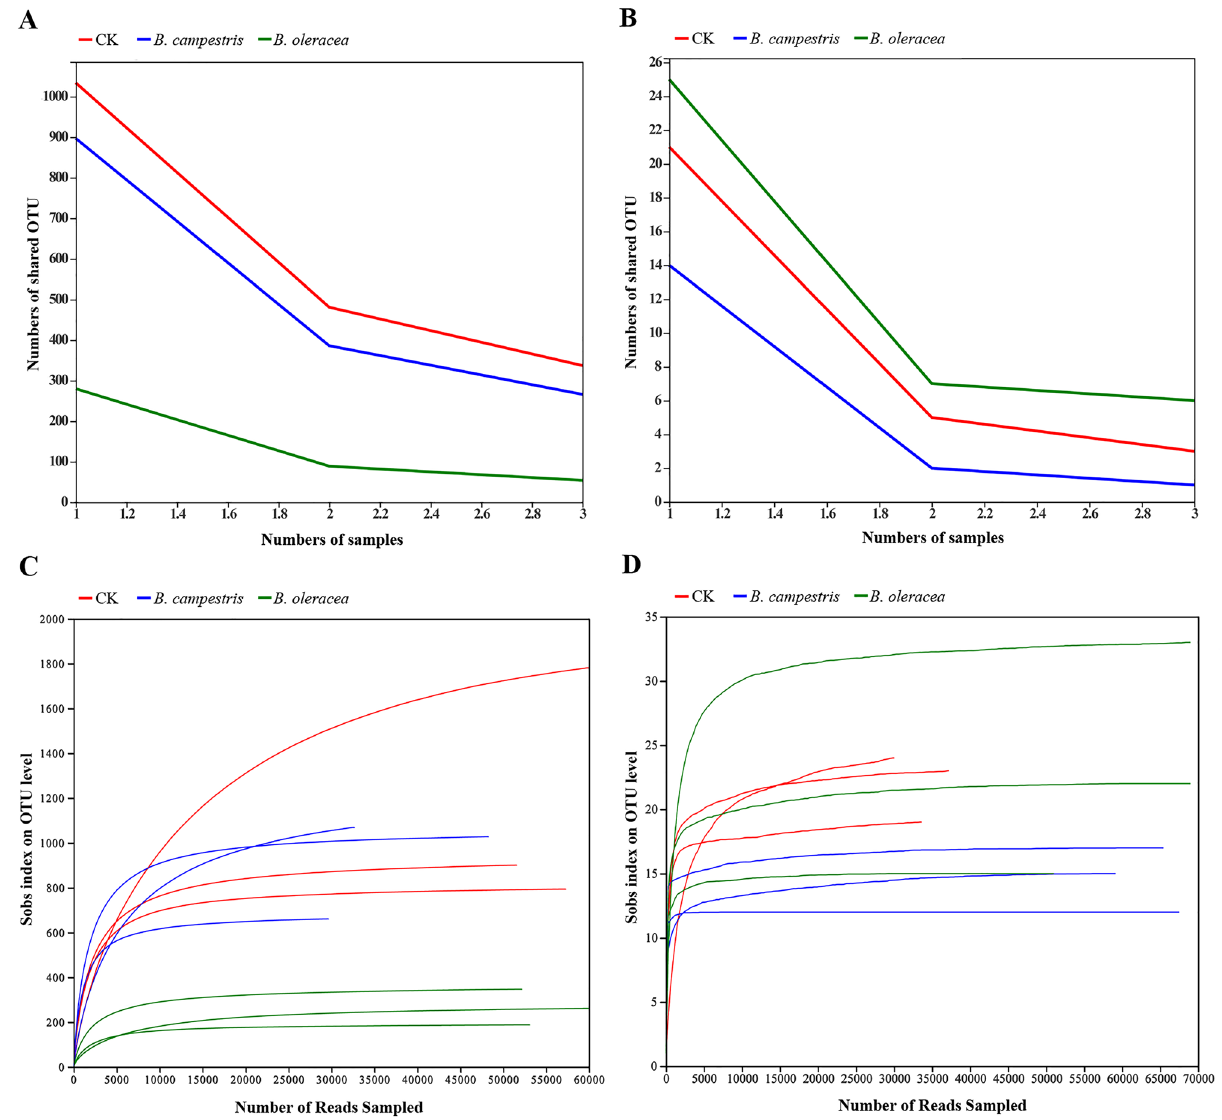
Figure 2. The quality analysis of OTUs in different samples. ( A ) OTU core analysis based on 16S rDNA sequencing. ( B ) OTU core analysis based on ITS sequencing. ( C ) OTU rarefaction curve derived from 16S rDNA sequencing. ( D ) OTU rarefaction curve derived from ITS sequencing. The figure was created by R project Vegan package (version 2.4–3) (https:// github. com/ vegan devs/ vegan/ relea ses/ tag/